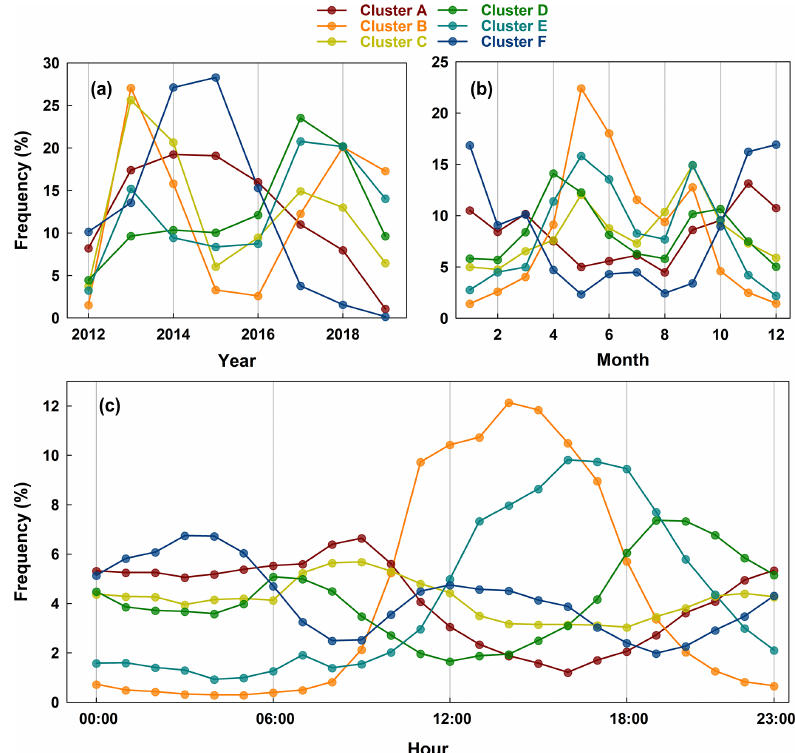
Figure 6. (a) Inter-annual, (b) average annual and (c) diurnal variations of occurrence frequencies for clusters A–F during the measurement